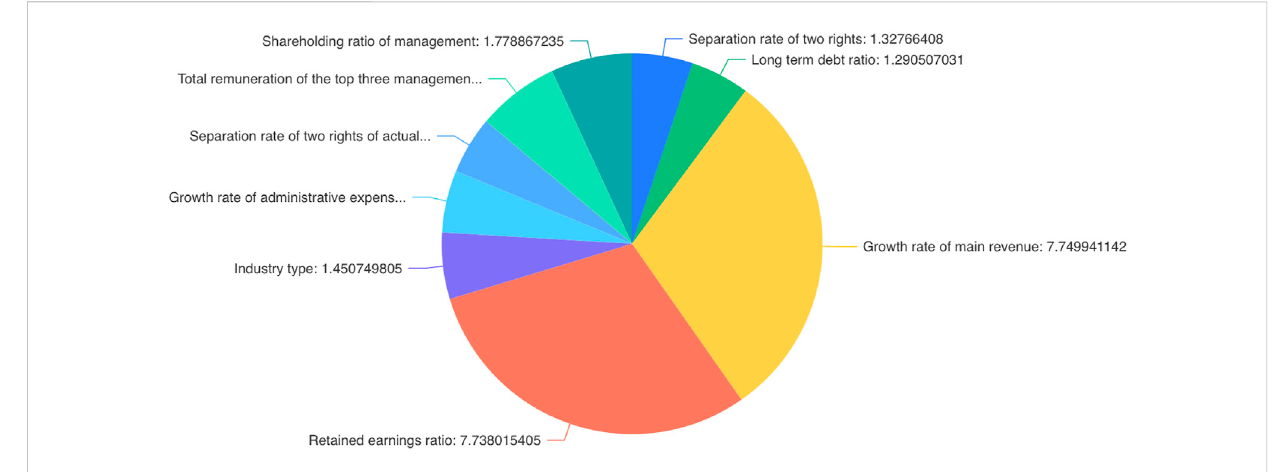
FIGURE 5 Variable score pie